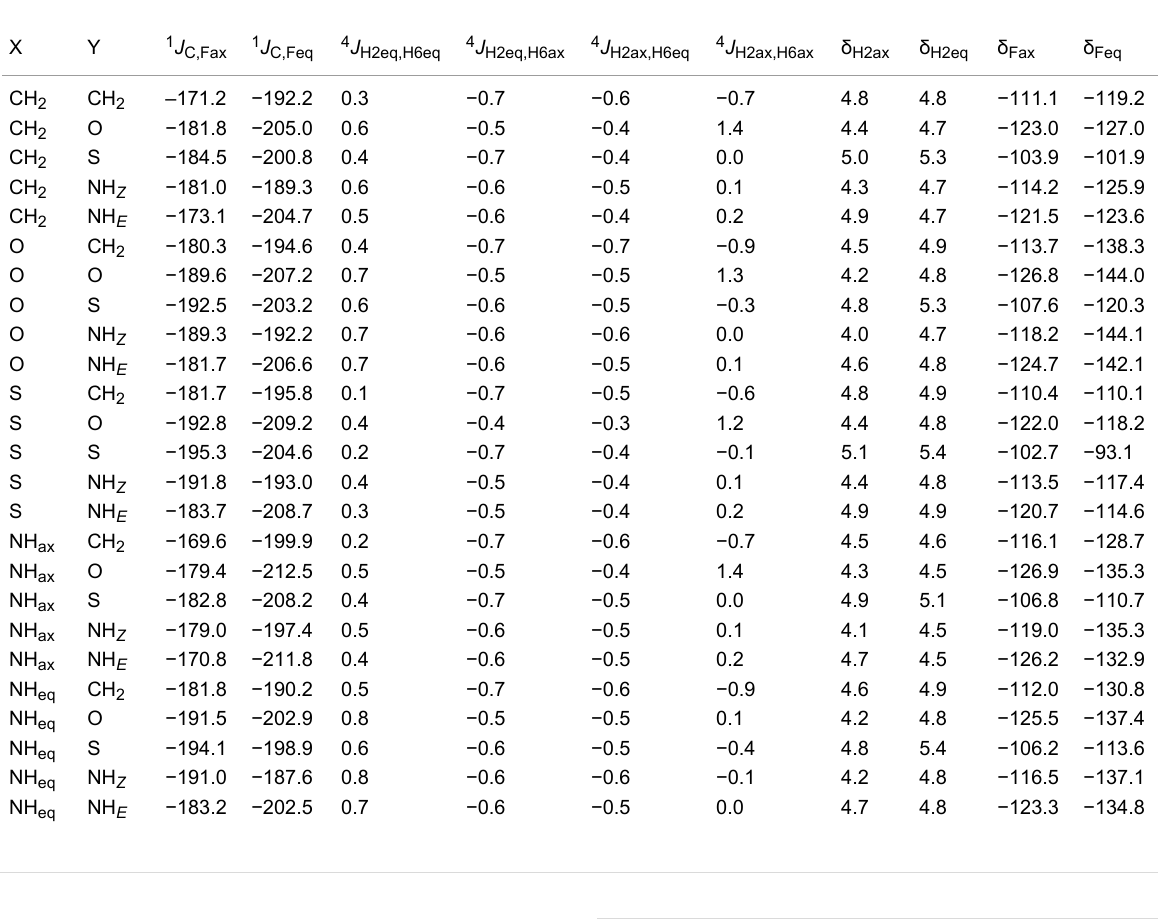
Table 4: Calculated NMR parameters ( J in Hz and δ in ppm, relative to TMS for 1 H and TFA for 19 F) in